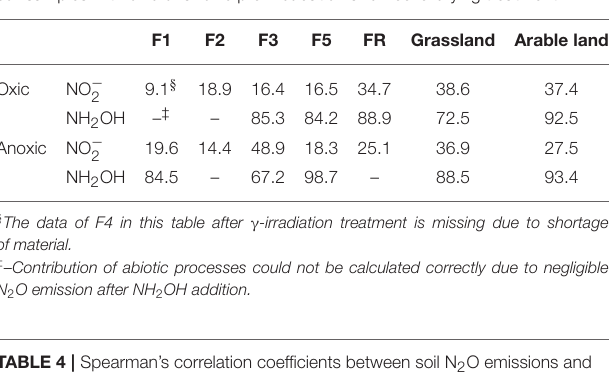
TABLE 3 | Contribution (%, n = 3) of abiotic pathways to soil N 2 O emissions after 7h incubation of soils with addition of aqueous solutions of NH 2 OH or NO − 2 to soil samples with oxic or anoxic pre-incubation and freeze-drying treatment.